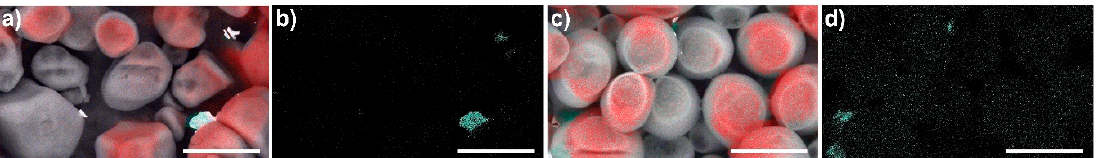
Figure 12. SEM-EDX elemental mapping of oxidized corn starch ( a , b ) and oxidized potato starch ( c , d ) at 10,000fold magnification. C is shown in red, O in blue, and Pb in green. Scale bar is 15 µm.